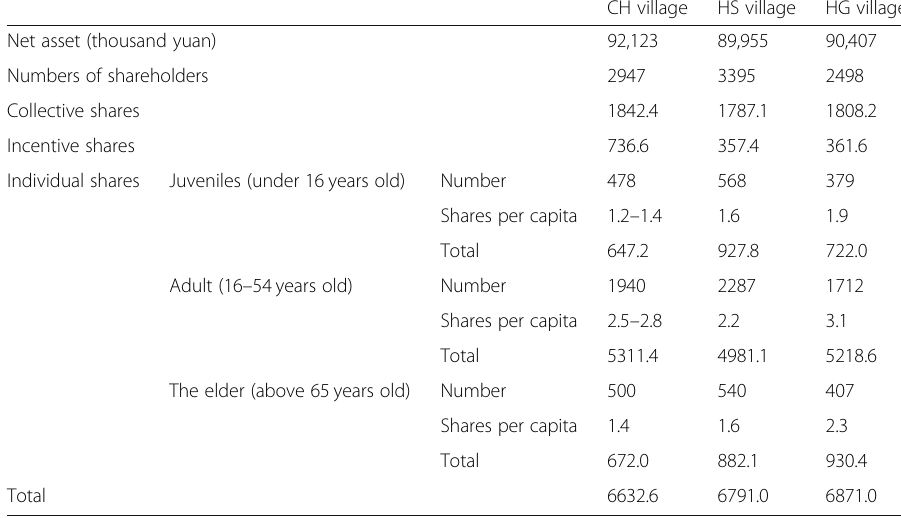
Table 3 Quantification table of three villages in HC